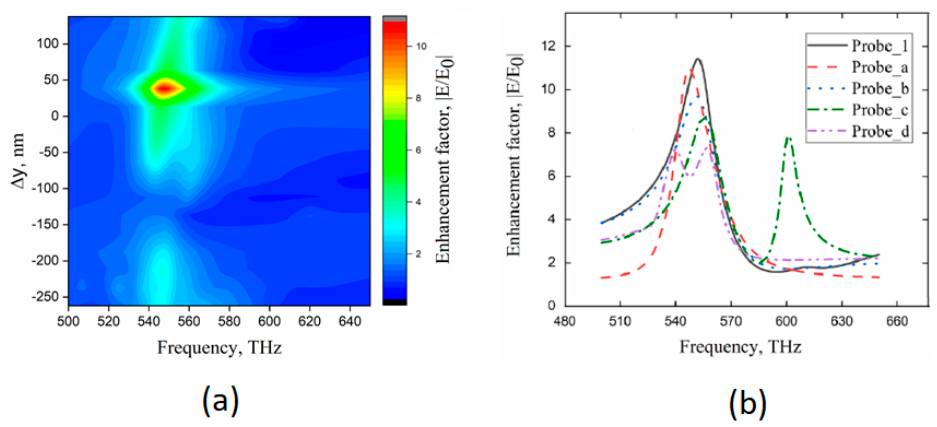
Figure 5. ( a ) Local field enhancement measured by Probe_a as a function of frequency and ∆ y; ( b ) frequency dependences of EF measured by different probes for the reference unit cell geometric parameters and ∆ y = 38 nm.